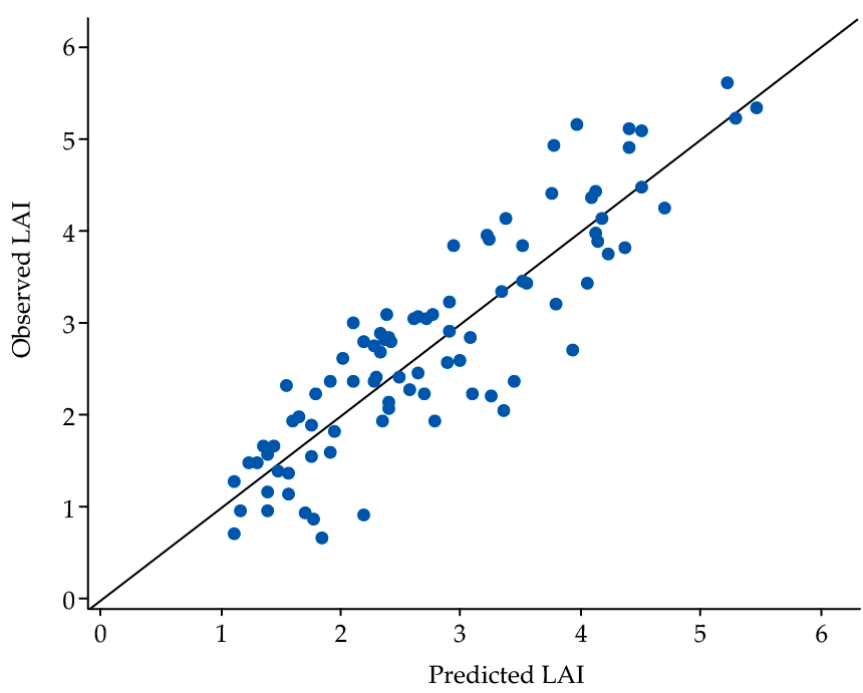
Figure 3. One to one graph of predicted LAI vs observed LAI. Table 5. Regression results between ground measured LAI and Landsat surface reflectance-based VIs (bold R 2 s denote the regression with the best fit for the given time period and Landsat sensor). * These results do not include an OLI image for the VA study site at minimum LAI in 2013.